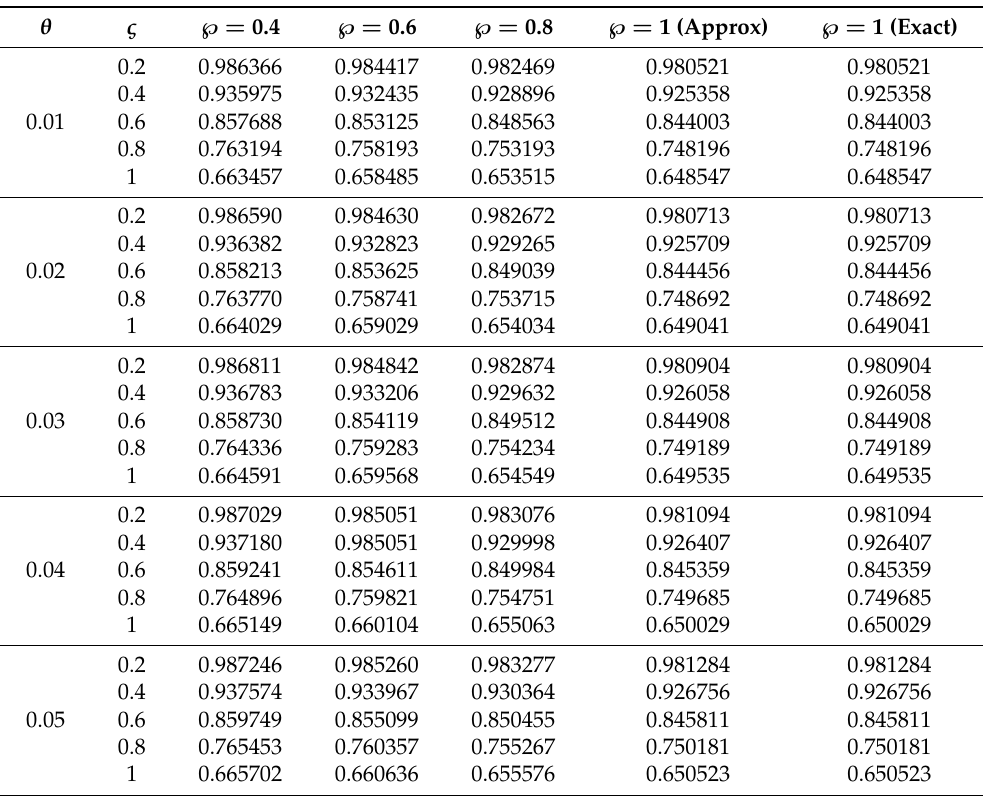
Figure 6. The obtained solution is graphically depicted for various order of ℘ in ( a ) three dimensions and ( b ) two dimensions. Table 1. Behavior of both the obtained approximate solution and exact solution are considered for various orders of ℘ , for example,